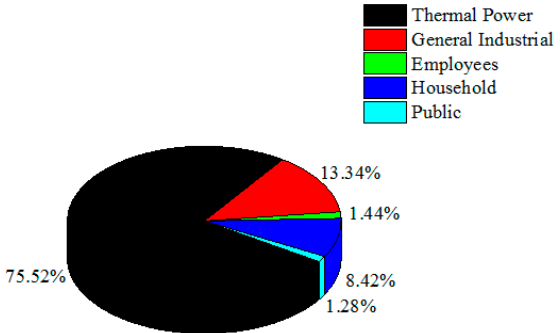
Figure 3. Proportions of energy consumption among the di ff erent categories of water utilization in the city of Ordos, China, in 2017.